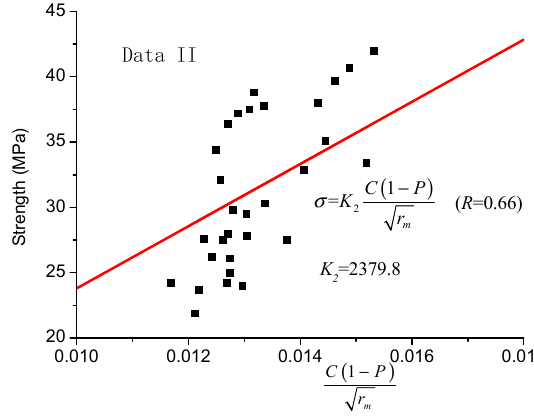
Figure 3. Equation (6) strength model (data II).